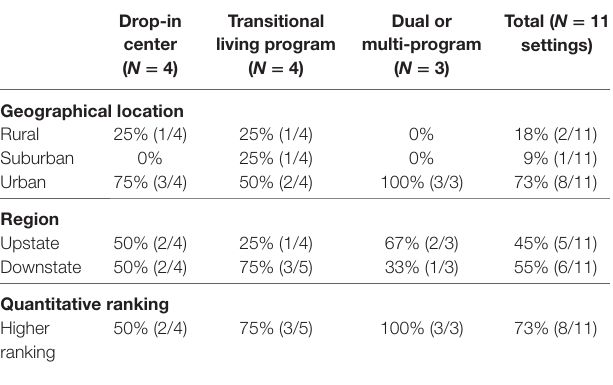
Table 1 | Description of settings